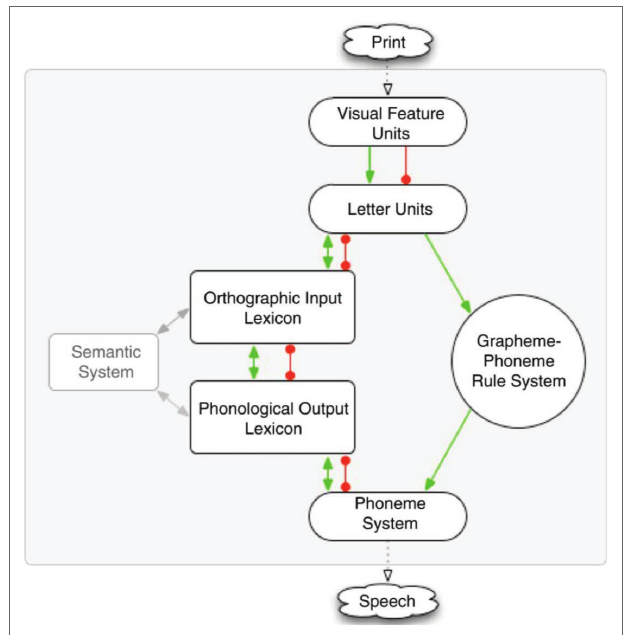
FIGURE 1 | The DRC model (Coltheart et al.,